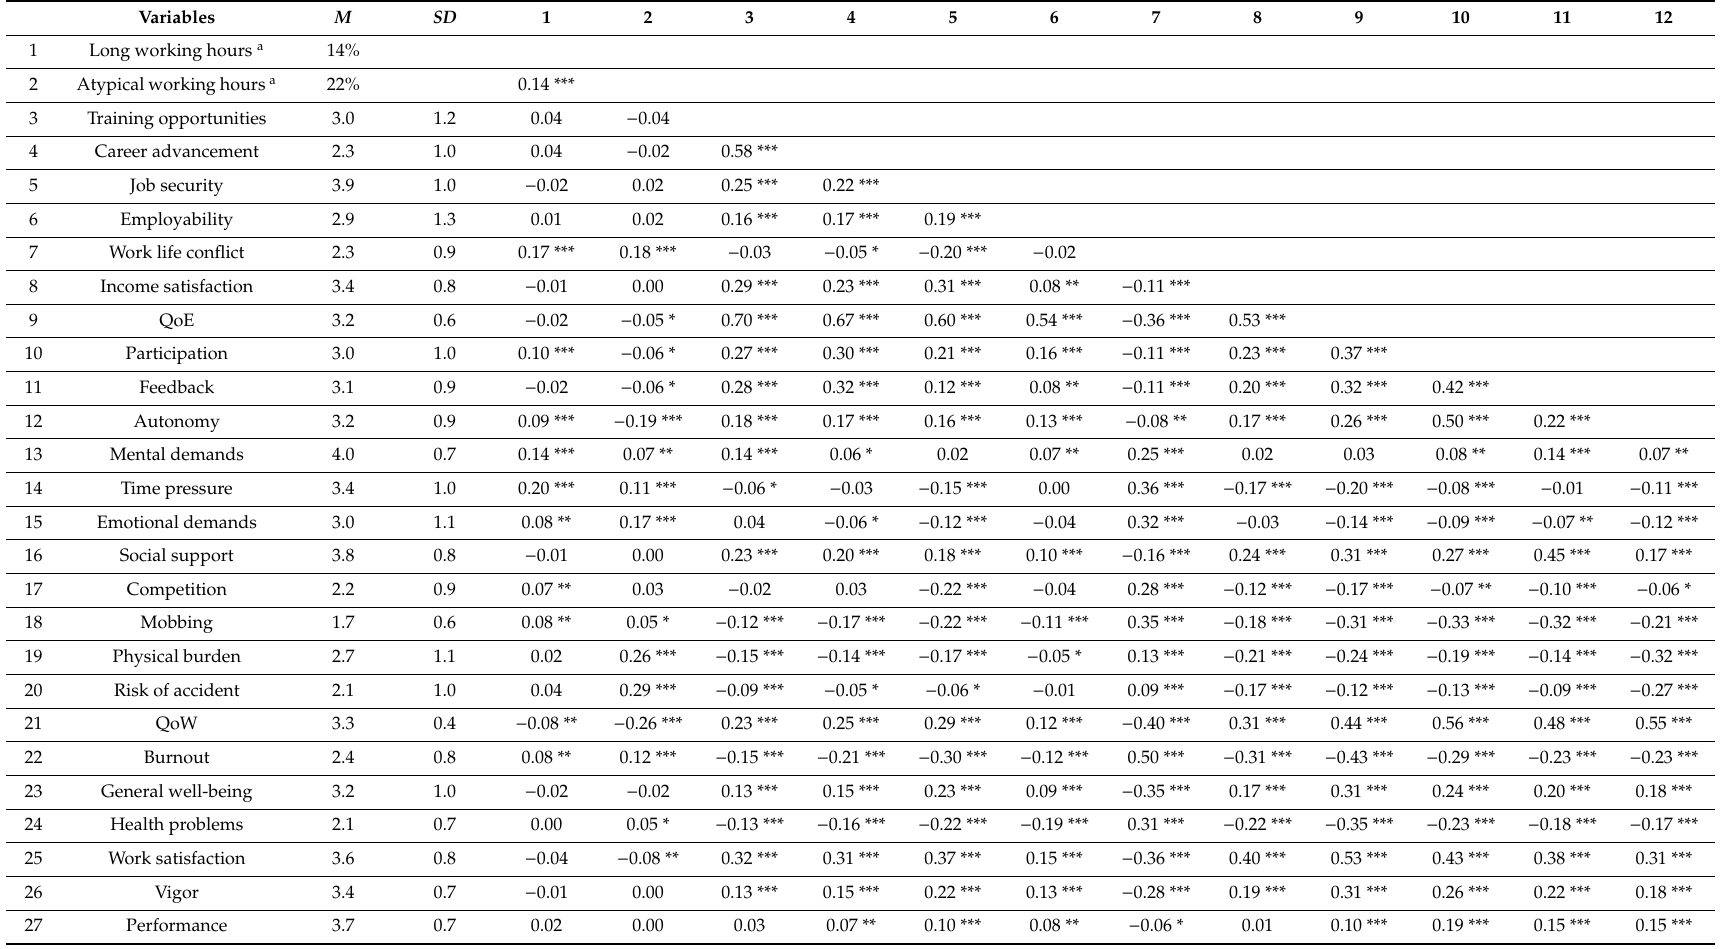
Table 6. Intercorrelations between study